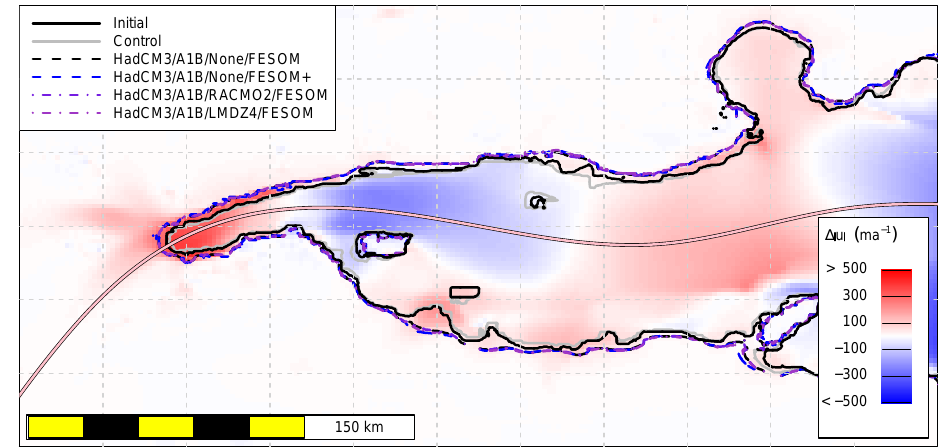
Figure 8. Ice flow acceleration and grounding line migration due to climate model forcing. The difference between final and initial ice flow speed ( 1 | u | (x,y) = | u(x,y,t = 2200 ) |−| u(x,y,t = 1982 | ) ) is shown for the HadCM3/A1B/None/FESOM experiment and exhibits acceleration of the Lambert, Fisher and Mellor glaciers and a mixture of acceleration and deceleration across the ice shelf. Initial and year 2200 grounding lines are shown for the simulations that have melt rates and surface mass balance data up to that point. The control shows advance in some regions while all four of the A1B/FESOM-forced runs retreat in the same way.